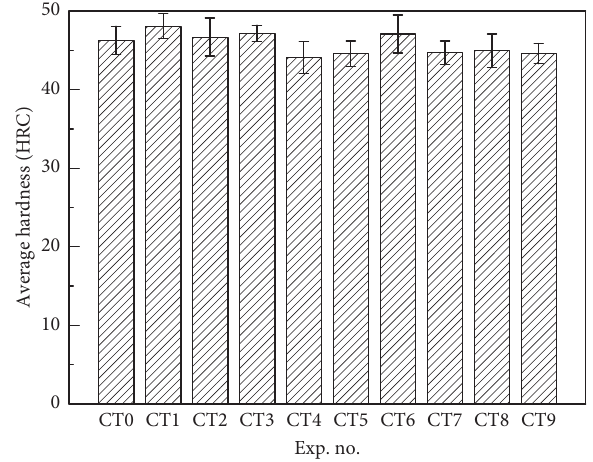
Figure 3: Average hardness with errors of